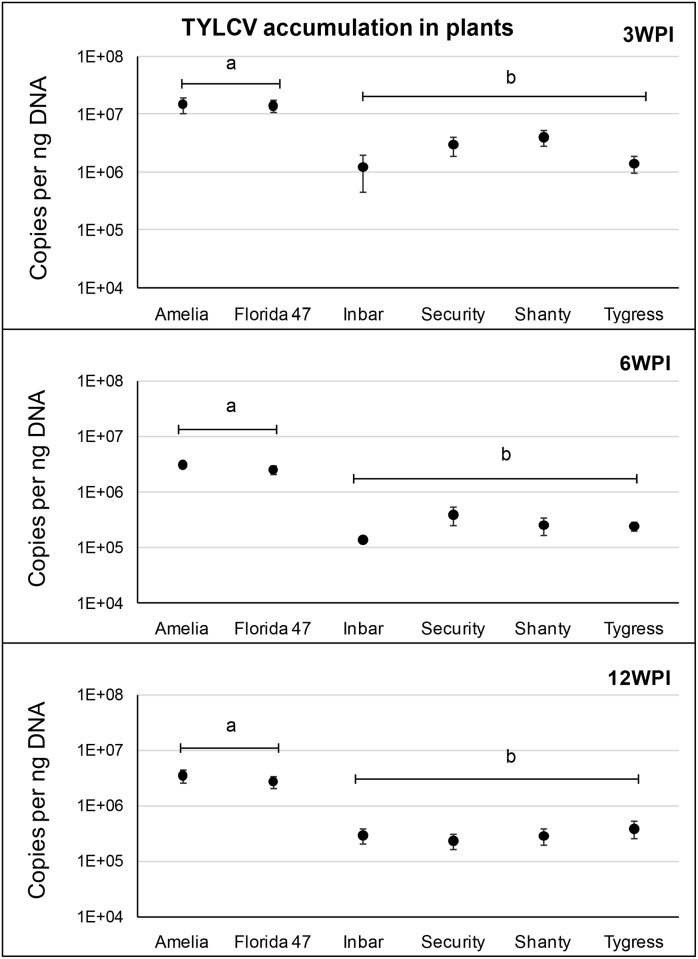
TYLCV accumulation in leaf tissue at 3, 6 and 12 weeks post inoculation (WPI).Circles with standard errors represent average number of TYLCV C2 copies accumulated in leaf samples from TYLCV-resistant and -susceptible genotypes (Amelia and Florida 47). Copy numbers were estimated by qPCR followed by absolute quantification using plasmids containing TYLCV C2 gene inserts as standards. Different letters on bars indicate significant differences in copy numbers among treatments as deduced by Tukey-Kramer grouping (α = 0.05). Y-axis is shown in a logarithmic scale.